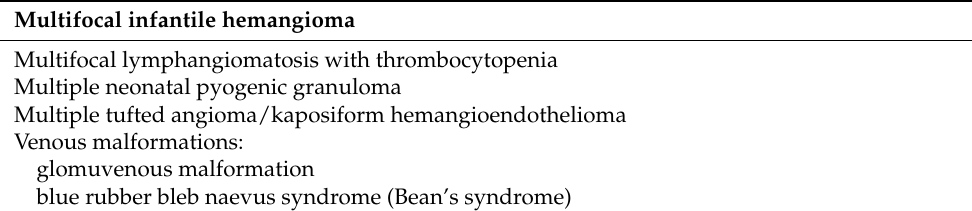
Table 2. Multifocal neonatal vascular skin lesions. Multifocal infantile